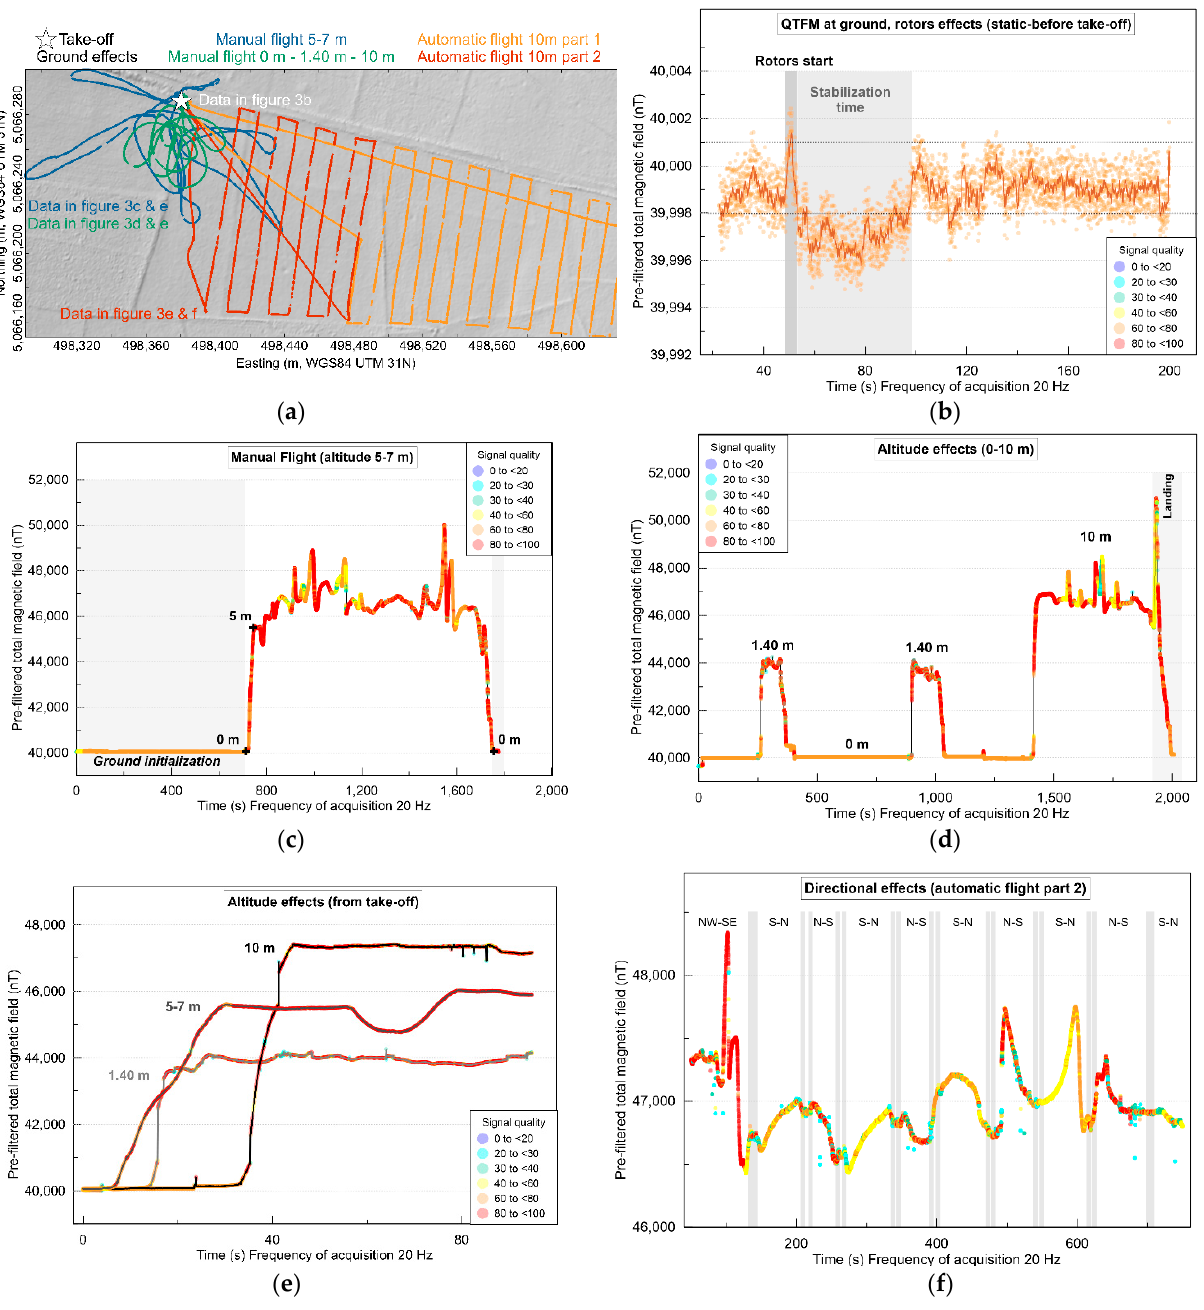
Figure 3. ( a ) Locations of the different test flights. ( b ) Static ground recording before, during, and after the rotors start. ( c ) Example of a recording over a complete manual flight. ( d ) Example of a recording over several manual flights at various altitudes, with intervening landings and take-offs. ( e ) Altitude effects from various flights for comparison (static flight at 1.40 m, manual flight at 5–7 m and automatic flight at 10 m). ( f ) Directional effects along the second part of the automatic flight (gyration points in grey area). Table 1. Statistics at crossing points for each flight.